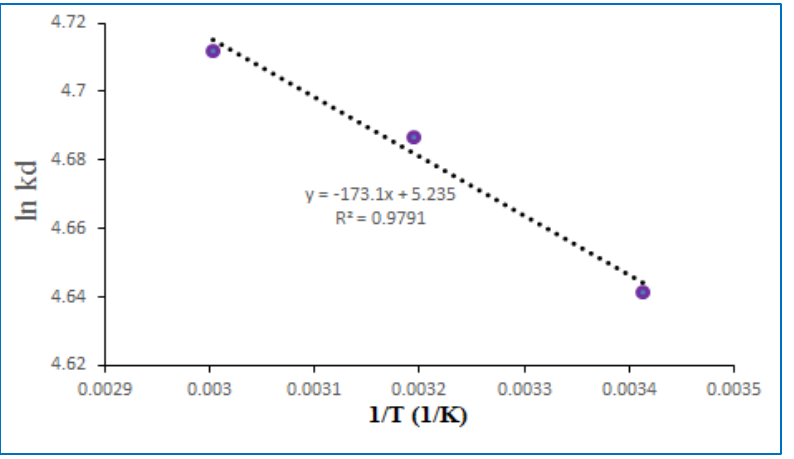
Figure 13. Thermodynamic studies of the adsorption of lead ions onto PPy-PEI nanoadsorbent.